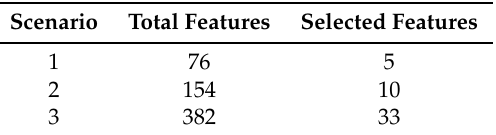
Table 8. Number of features selected by scenario.